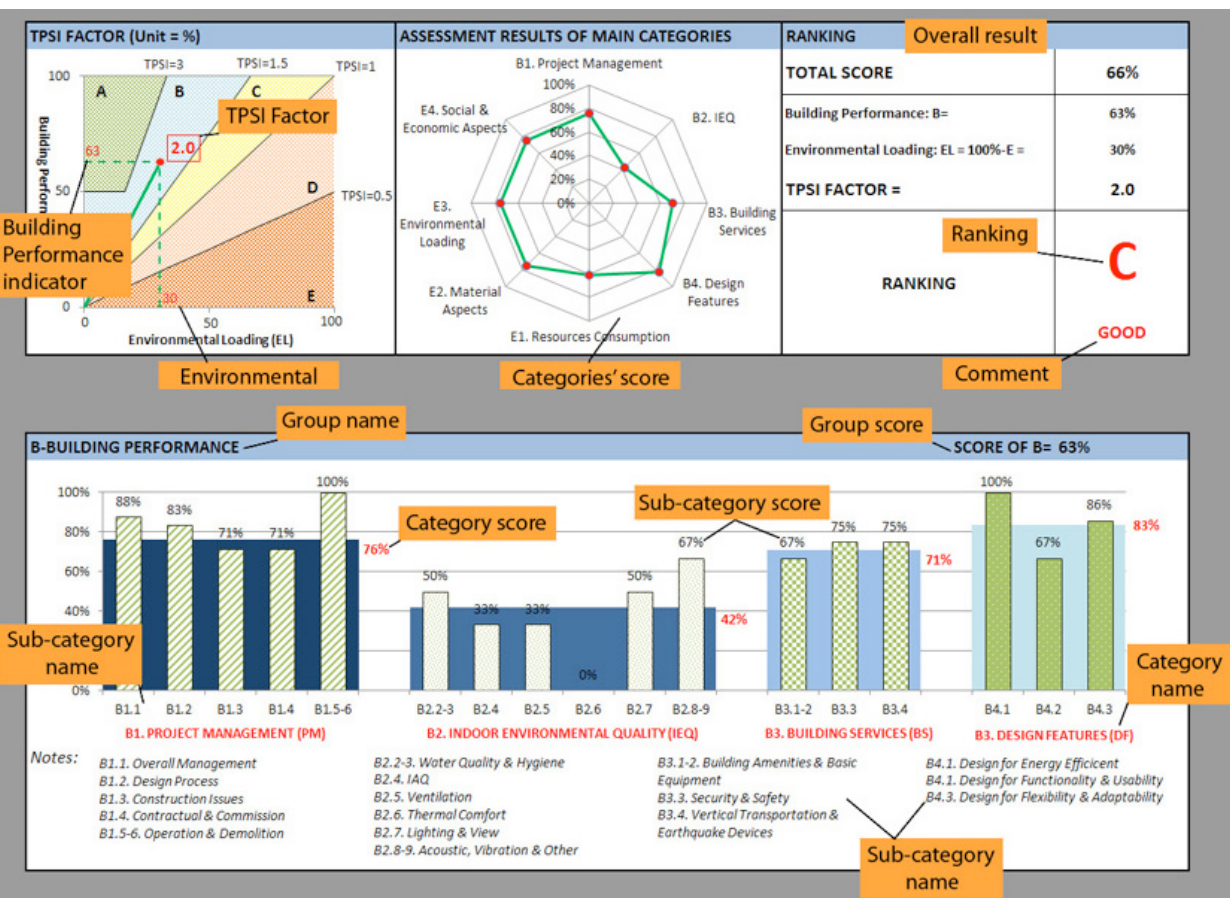
Figure 6. “Result” tab—screenshot.